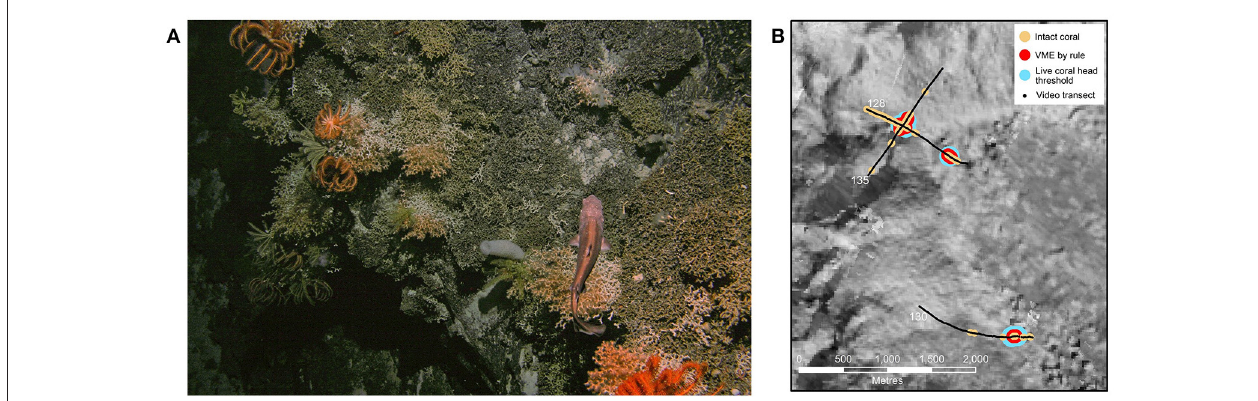
FIGURE 3 | (A) Seabed photograph showing coral reef habitat (live coral heads are lighter colored) and associated fauna including brisingids and crinoids (station 150, Valerie Guyot). (B) Illustration of VME habitat definition approach based on video transect observations, showing the occurrence of: all intact Solensmilia variabilis colony matrix (“intact coral”); VME coral reef habitat as defined by a “rule” (“VME by rule,” see methods text), and an abundance indicator of VME coral reef habitat (“live coral head threshold”) based only on a minimum threshold for live Solensmilia variabilis heads derived from their occurrence in the “VME by rule” areas. Black lines show full video transect paths (numbers = station number). This example is from the northwest flank of Ghost Seamount.